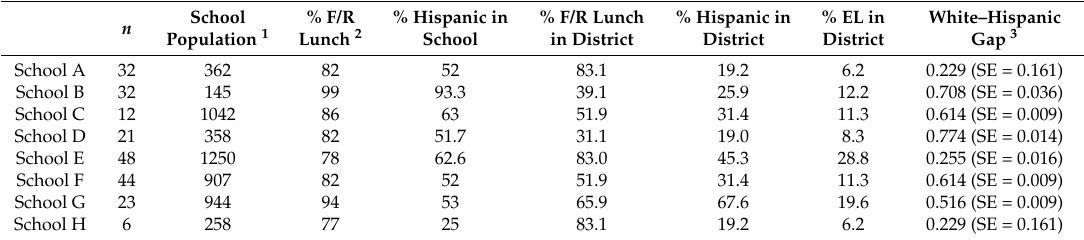
Table 2. Description of participating schools.